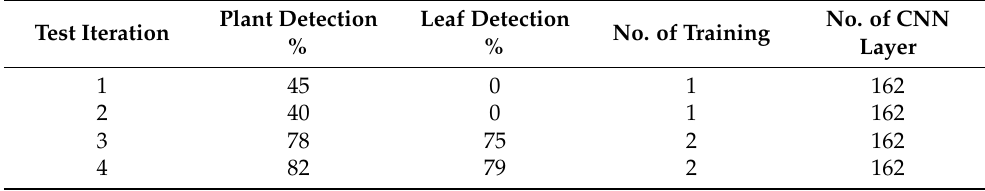
Table 1. Learning and testing details.